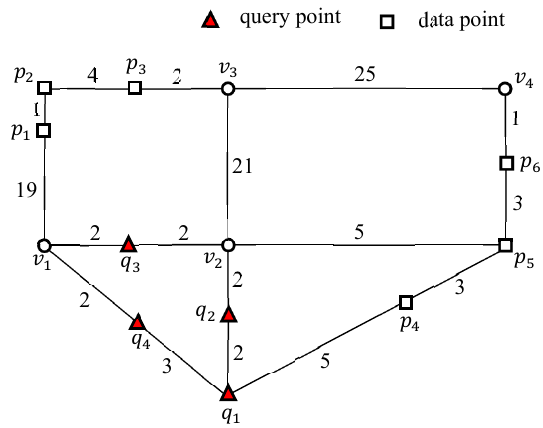
Figure 2. Example of k FN join Q (cid:110) P in a spatial